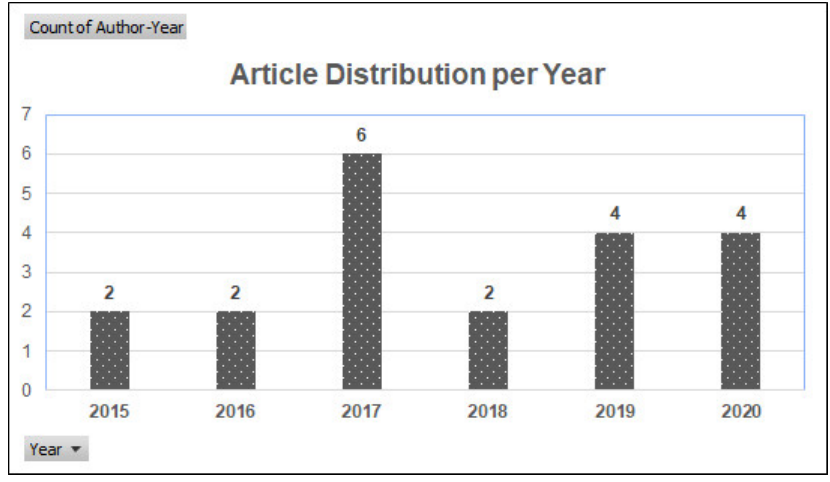
Figure 3. Distribution graph of the number of articles per year.